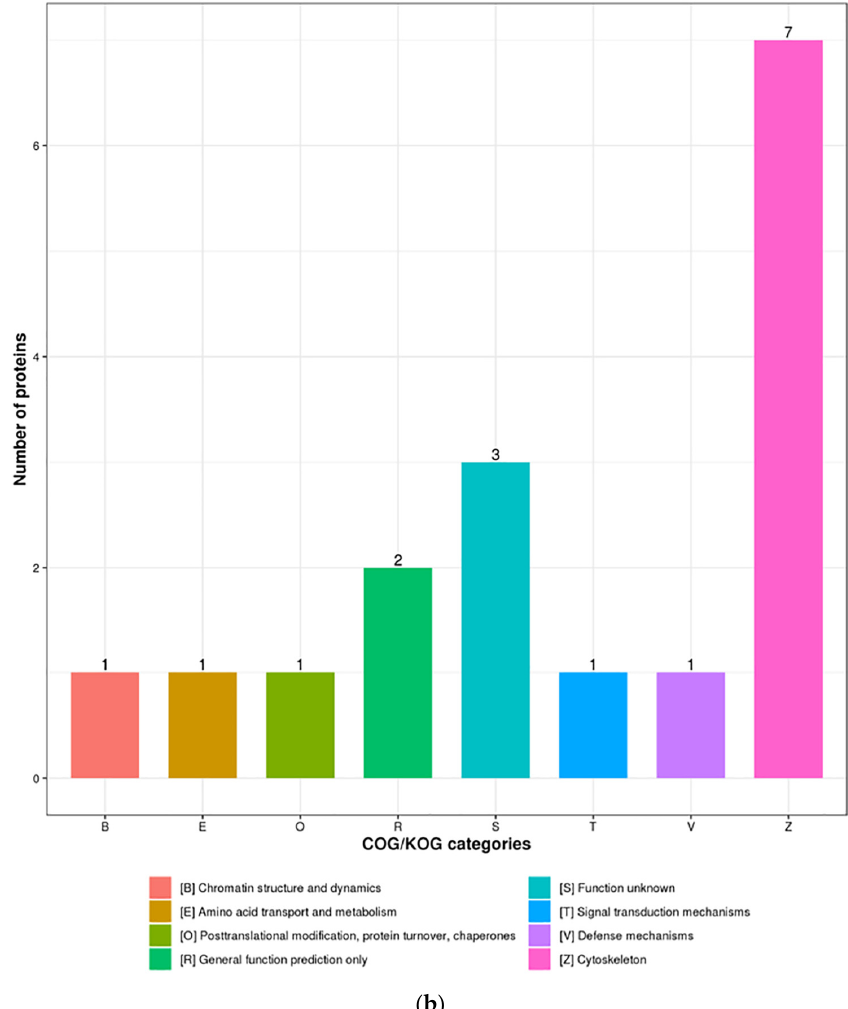
Figure 3. Subcellular localization and COG/KOG functional classification of the 24 DEPs. ( a ) Sub- cellular localization analysis of the 24 DEPs. ( b ) COG/KOG analysis of the 24 DEPs. Clusters of orthologous groups of proteins are named COG/KOG. The proteins that make up each COG/KOG are assumed to be derived from an ancestral protein. Therefore, the proteins in the same COG/KOG are considered orthologs or paralogs. Orthologs refer to proteins from different species that have evolved from vertical families (species formation), and characteristically preserve the same function as the original protein.